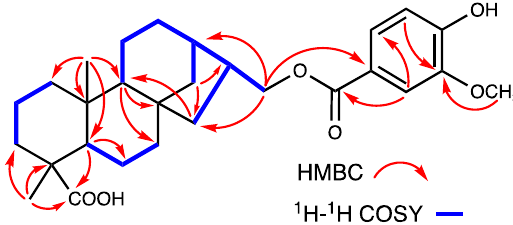
Figure 6. Key 2D-NMR correlations of compound 22.